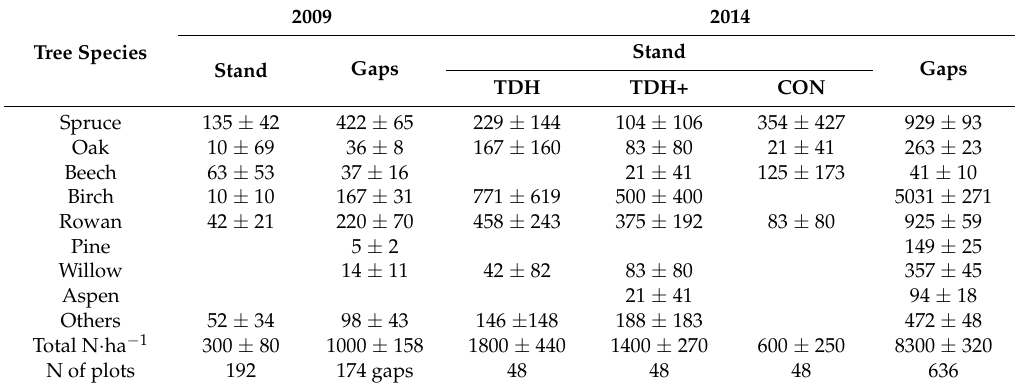
Table 4. Number of seedlings ha − 1 and standard error by tree species (height 20–200 cm) before and after